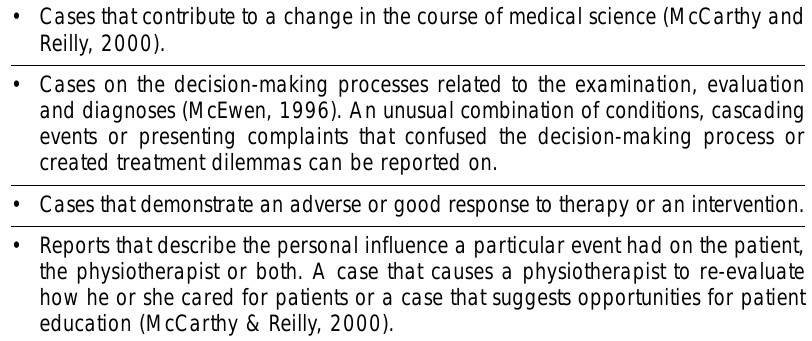
Table 1: Cases suitable for case